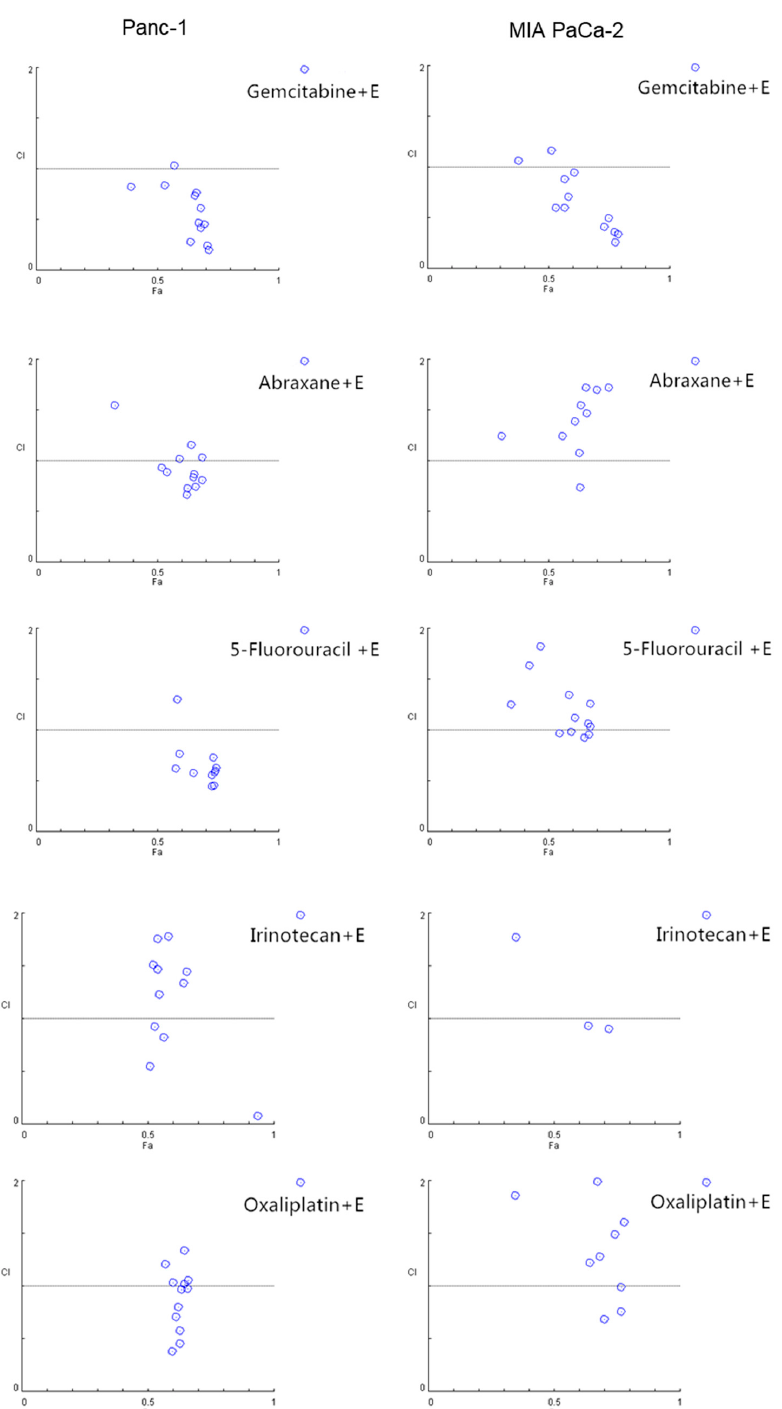
Figure 4. EGCG enhances the cell growth inhibitory effect of gemcitabine in pancreatic cancer cells. Combination index (CI) plots of EGCG (20, 40, 60 μ M) in combination with gemcitabine (1, 10, 20 and 40 nM), abraxane (1, 10, 20 and 40 nM), 5-Fluorouracil (1, 10, 20 and 40 μ M), irrinotecan (1, 10, 20 and 40 μ M), and oxialiplatin (1, 10, 20 and 40 μ M) in Panc-1 (left) and MIA PaCa-2 (right) cells. Drug interactions were quantitatively determined using the Chou–Talalay method, and CI < 1, =1, and >1 indicates synergism, additive and antagonism e ff ect, respectively. Of note, the CI value dots depicted are based on concentrations of EGCG and the chemotherapeutic drugs shown on Table